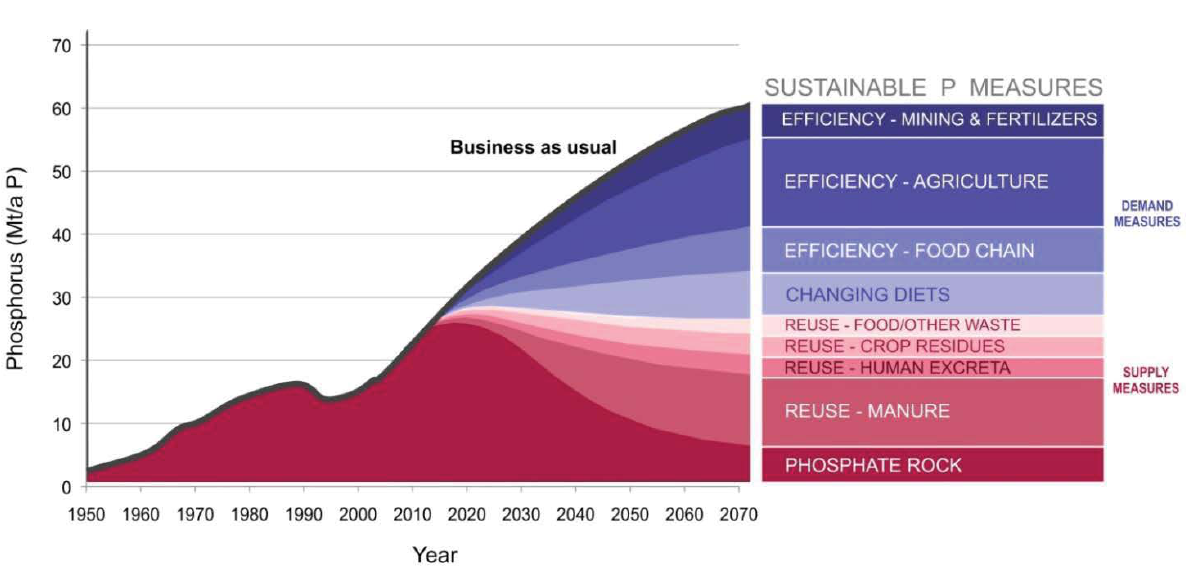
Figure 1. Sustainable phosphorus supply and demand measures for meeting long-term future global food demand. Adapted from Cordell et al. [21].